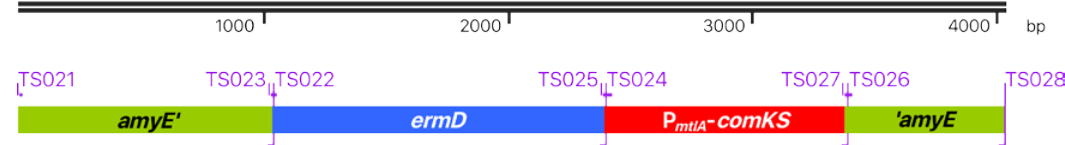
Figure 1. ermD -P mtlA - comKS super-competence cassette. The modified super-competence cassette consists of the amyE homolog regions amyE ’ and ’ amyE for recombination with the genome of Bacillus subtilis Δ6, the ermD erythromycin selection marker, and the P mtlA -comKS competence cassette with the genes comK and comS under the control of the D -mannitol-inducible P mtlA promotor. Primers used for the construction are shown on the border of each element.